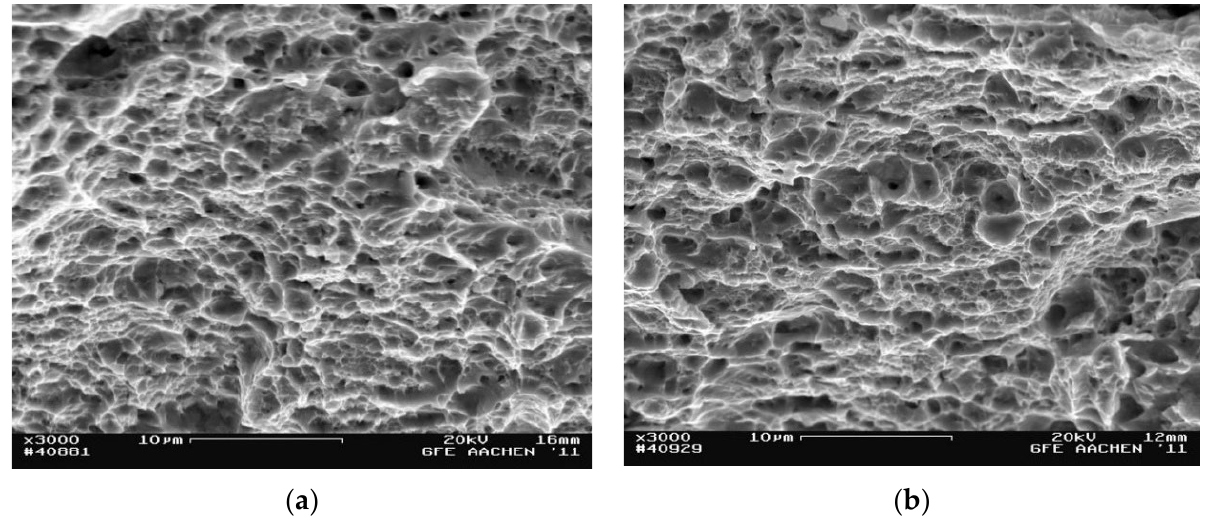
Figure 5. Fractography of the fracture surface in the crack start zone: ( a ) at cryogenic temperature; ( b ) at room temperature.